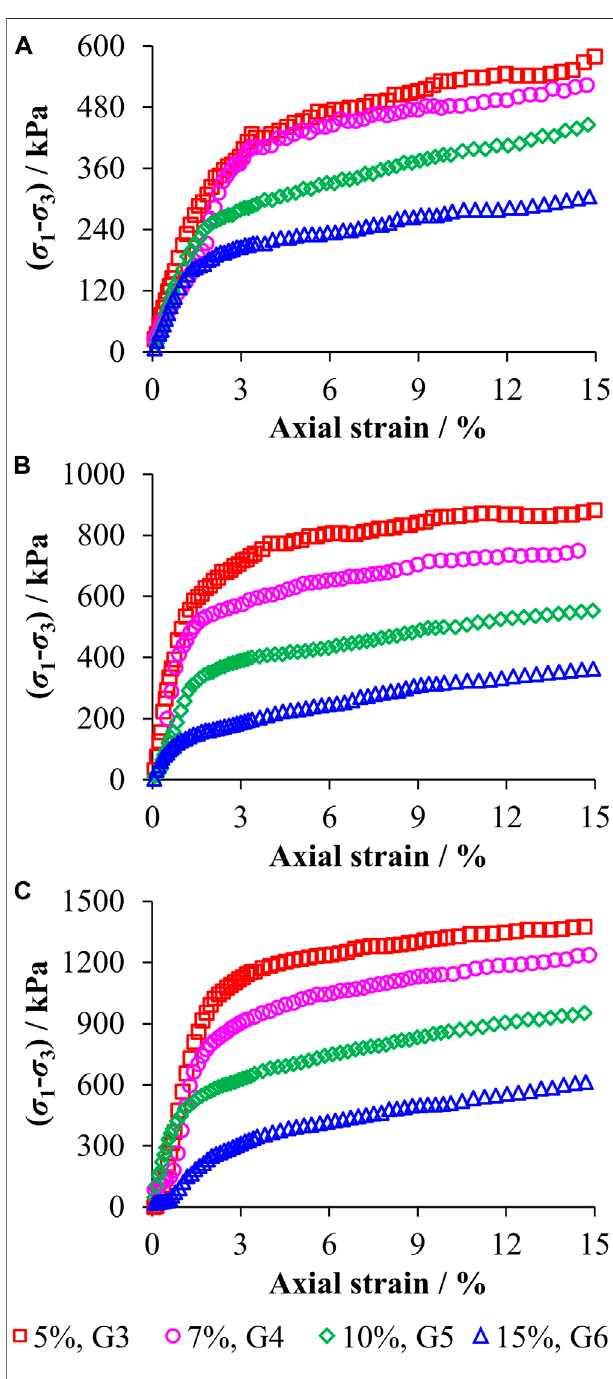
FIGURE 4| Stress – strain responsesofTCS with different mass ratios of silica powder (the amount of fused quartz varies with the mass ratios of silica powder) at con fi ning pressures of 50 (A) , 100 (B) , and 200 kPa (C)